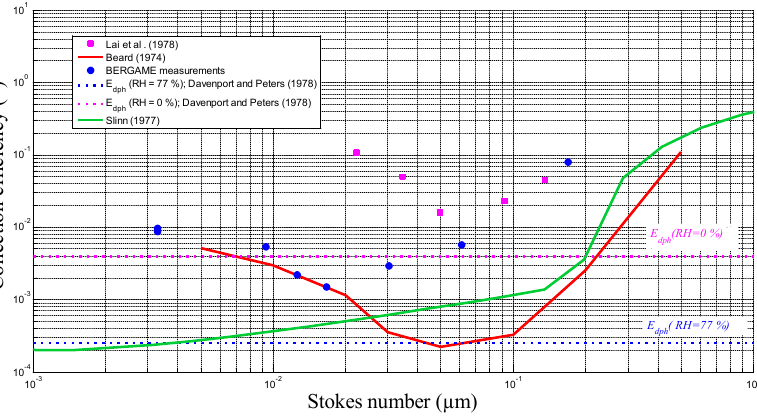
Figure 12. Collection efficiencies measured in this study and by Lai et al. (1978). Both measurements are compared to the Slinn (1977) and Beard (1974) models. The contribution of diffusiophoresis in both studies is computed following the description of Davenport and Peters